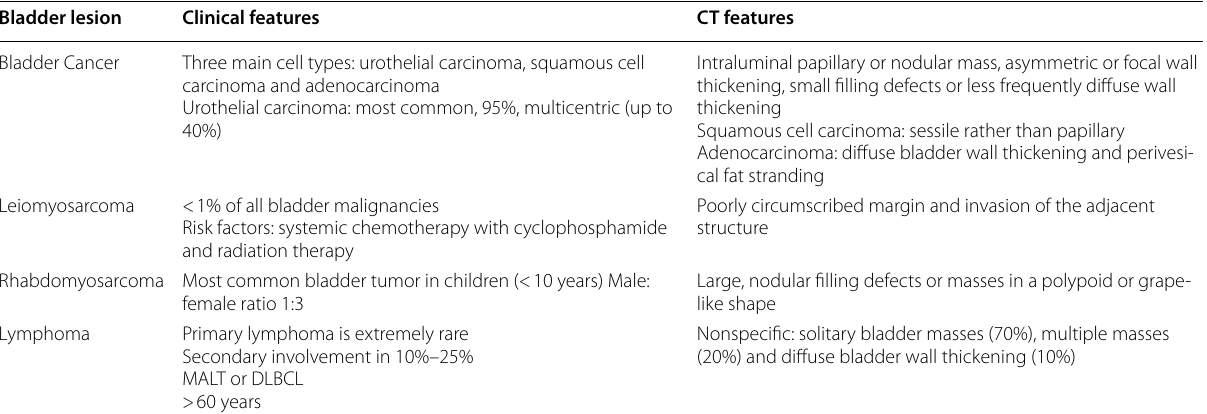
CT—computed tomography; MALT—mucosa-associated lymphoid tissue; DLBCL—diffuse large B-cell lymphoma